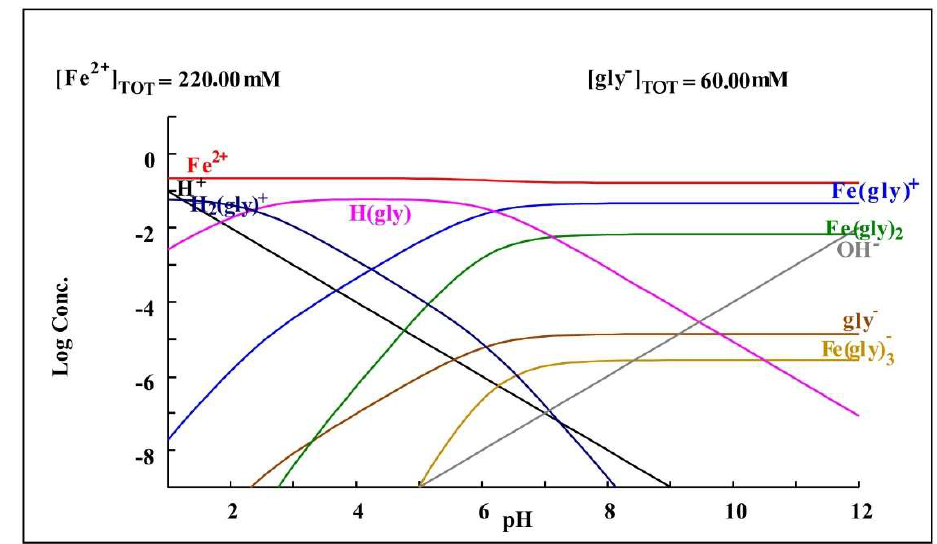
Figure 8. Diagram of distribution of species of the Fe 2+ -glycine − system based on the concentrations present in the leaching medium. Diagram made by the authors in Medusa software version 2010.